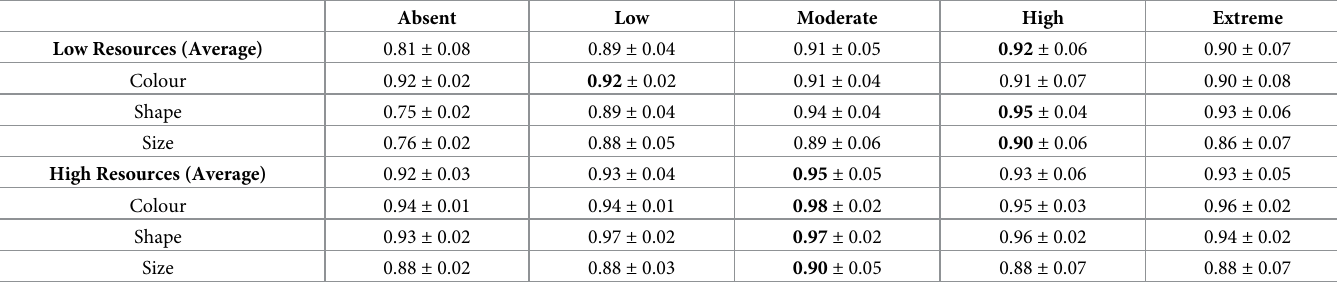
Table 2. Performance of models with different RL contributions in correspondence to two different amounts of computational resources (number of neurons in the second hidden layer of the DBN) and three different sorting rules (colour, shape,